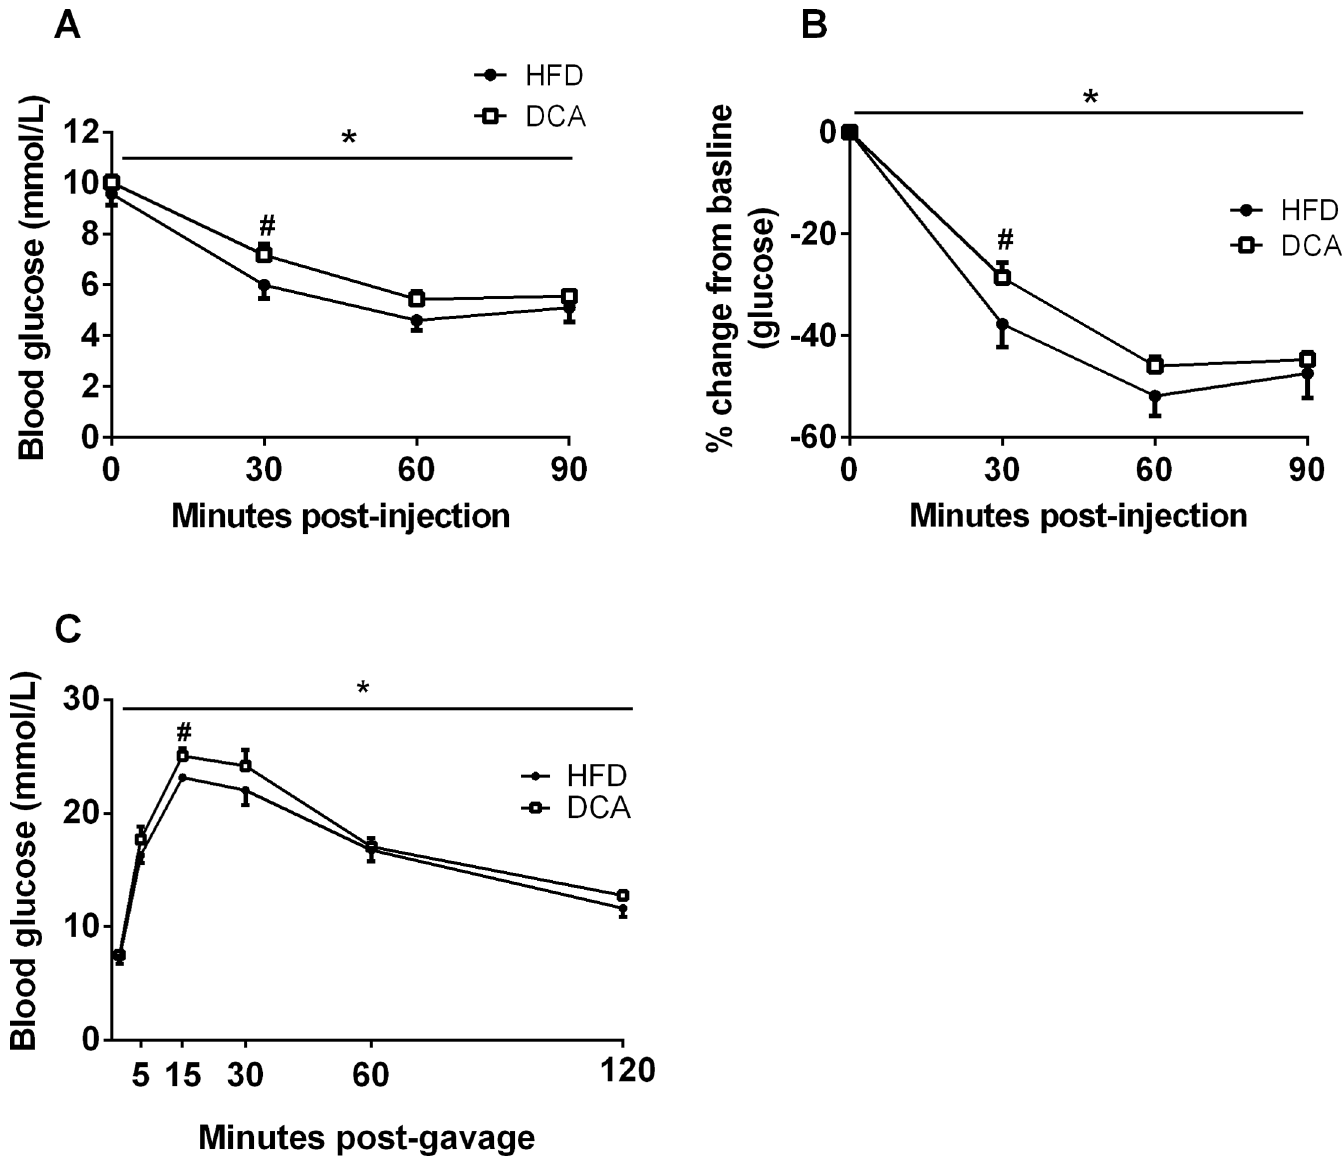
Fig 4. DCA supplementation impairs glucose homeostasis. Absolute blood glucose concentrations (A) and percentage change from baseline blood glucose concentrations (B) during an insulin tolerance test. (C) Blood glucose concentrations during an oral glucose tolerance test. Data are expressed as mean ± SEM, (cid:3) P < 0.05 by two-factor ANOVA, # P < 0.05 by Student’s t-test, n = 8 per group.